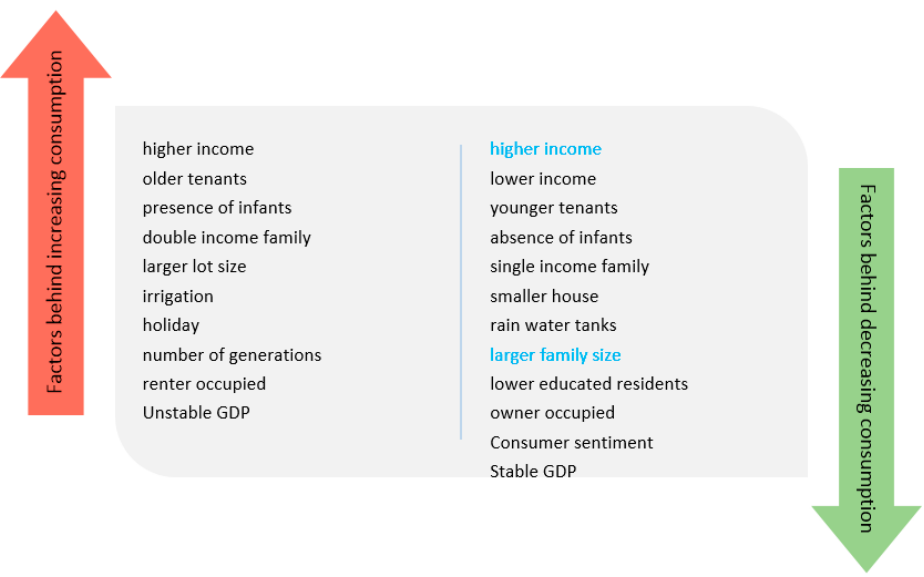
Figure 7. Socioeconomic factors that determine water consumption from mains water.